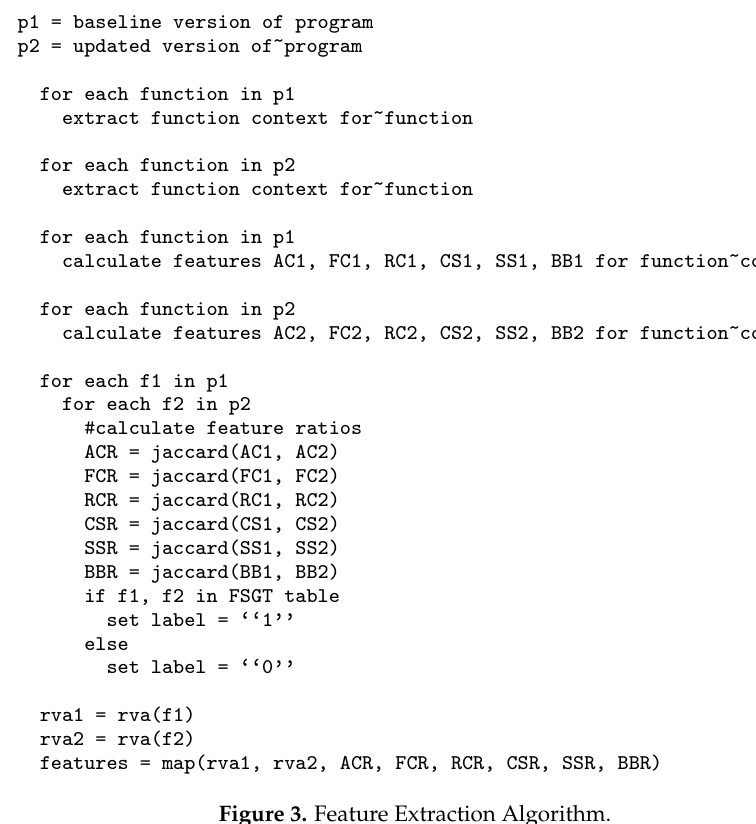
Figure 3. Feature Extraction Algorithm.